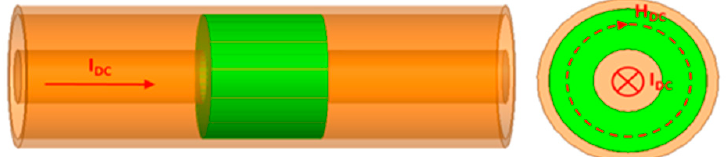
Figure 7. APC7 measurement cell loaded with a ferrite toroidal sample. Both DC and AC magnetic fields have orthoradial symmetry (only H DC is represented).